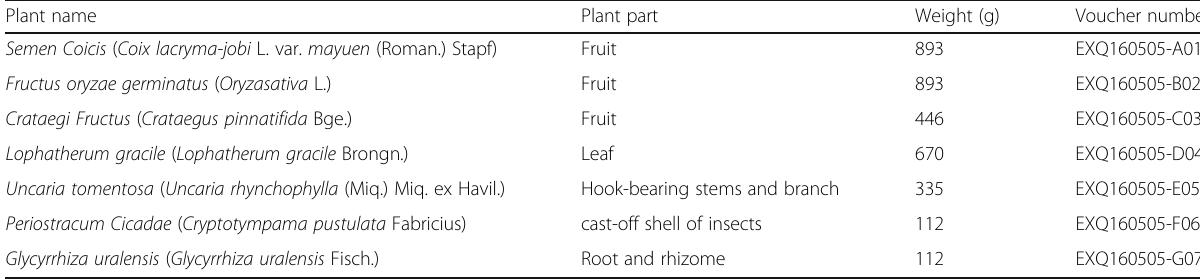
Table 1 Components of Xiao ’ er Qixingcha